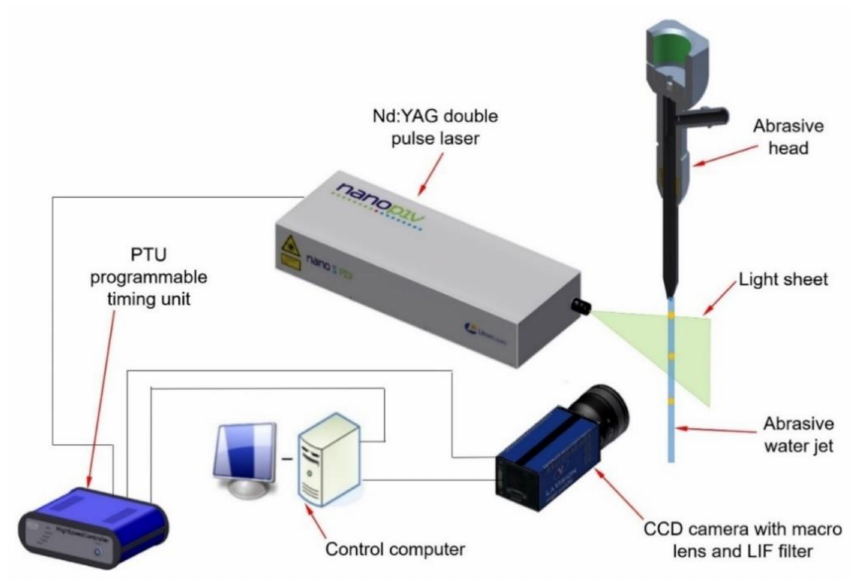
Figure 6. Planar PTV setup for the abrasive water jet visualisation. Under every tested pressure, a series of 100 double images were made. First, a subtracted offset algorithm was used to suppress the noise from the image background.